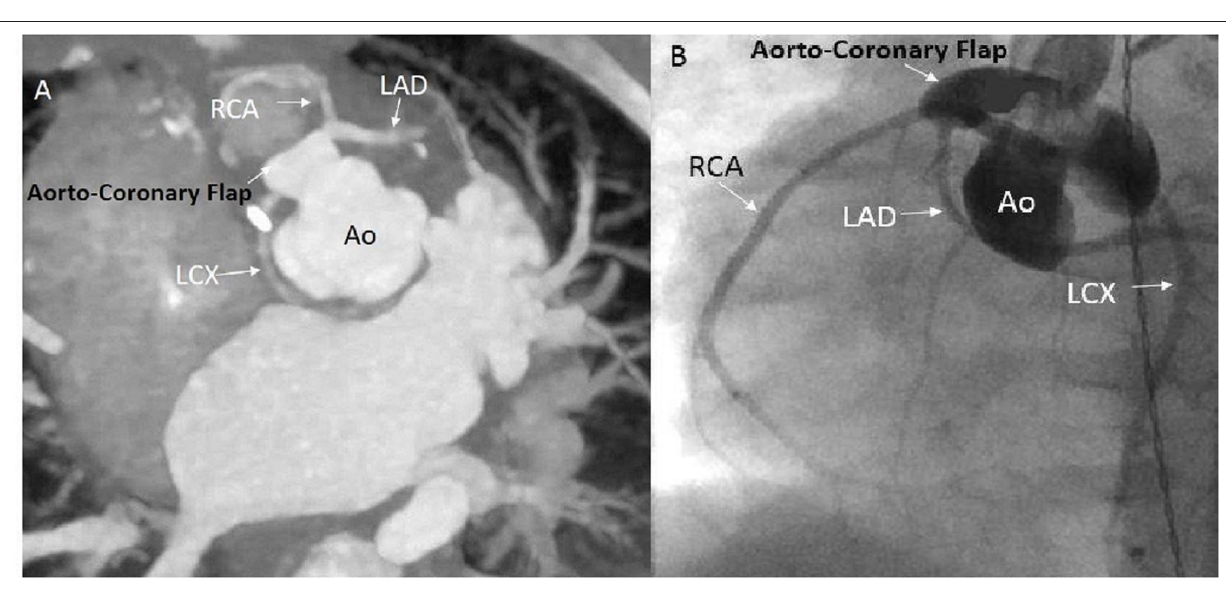
FIGURE 4 | Computed tomography angiogram (CTA) and routine angiogram images obtained after the un-roofing procedure. (A) CTA showing the aorto-coronary flap with widely patent coronary arteries. (B) Angiogram showing the aorto-coronary flap with widely patent coronary arteries. Ao, Aorta; RCA, right coronary artery; LAD, left anterior descending coronary artery; LCX, left circumflex coronary